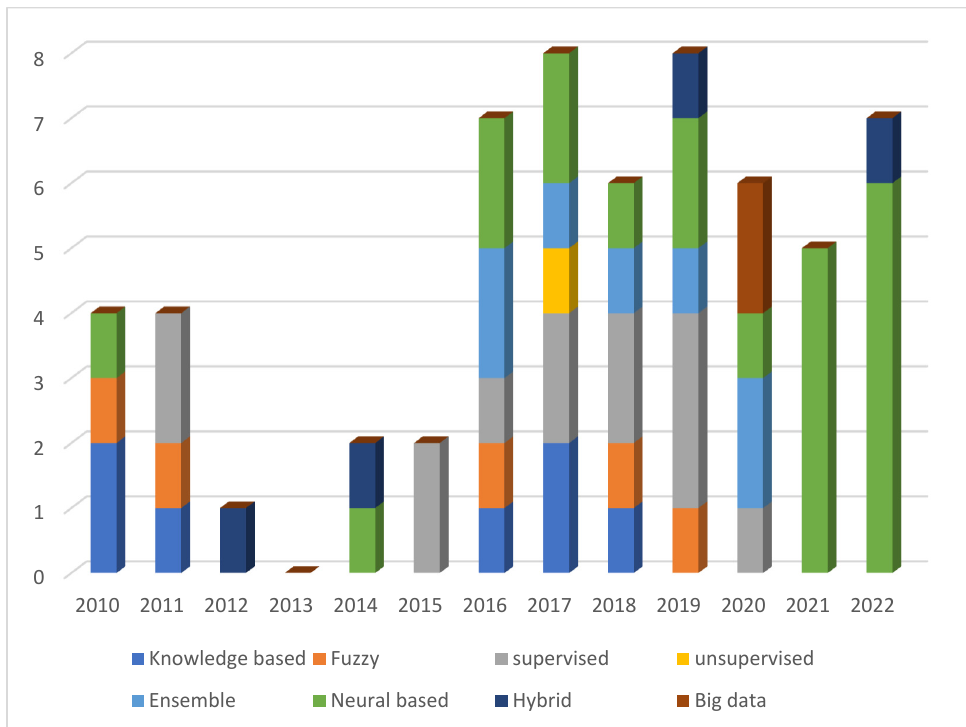
Figure 12. Trends in publications on ES/DSS ‐ based ECG interpretations in the last decade .